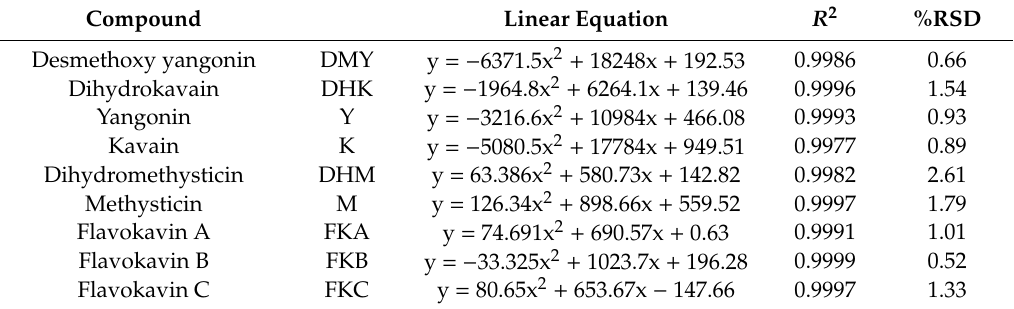
Table 1. Linearity of HPTLC measurements, accuracy and precision of repetitions (peak areas versus concentrations